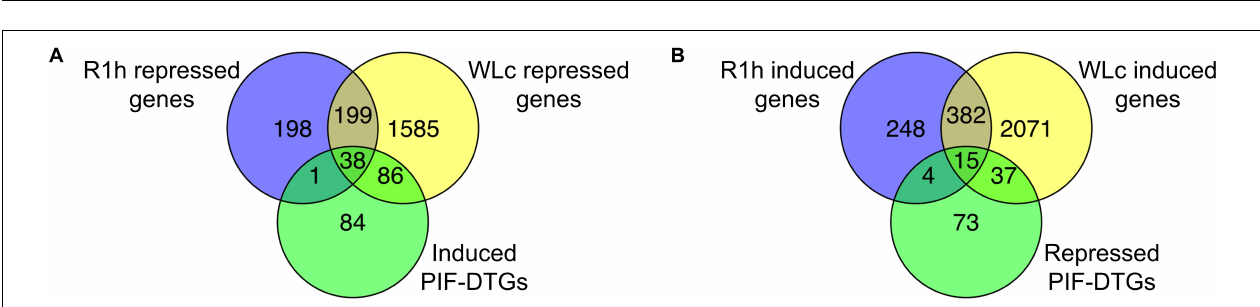
FIGURE 2 | A subset of PIF-DTGs are induced or repressed after a short exposure to red light, and a larger set of genes change expression under continuous white light conditions. (A) 39 PIF-induced DTGs are repressed after 1 h of red light, and 86 additional genes are repressed in continuous white light, totaling 125 out of 209 PIF-induced DTGs (60%). (B) 19 PIF-repressed DTGs are induced after 1 h of red light, and 37 additional genes are induced in continuous white light, totaling 56 out of 129 PIF-repressed DTGs (43%). Only genes with a statistically significant (FDR < 0.05) two-fold change in expression under different treatments are compared. PIF-DTGs are defined in Pfeiffer et al. (2014) as genes whose promoter region is bound by one or more PIF quartet members at a G-box or PIF Binding Element, and whose transcript levels are misregulated in pifq mutant plants grown in the dark.